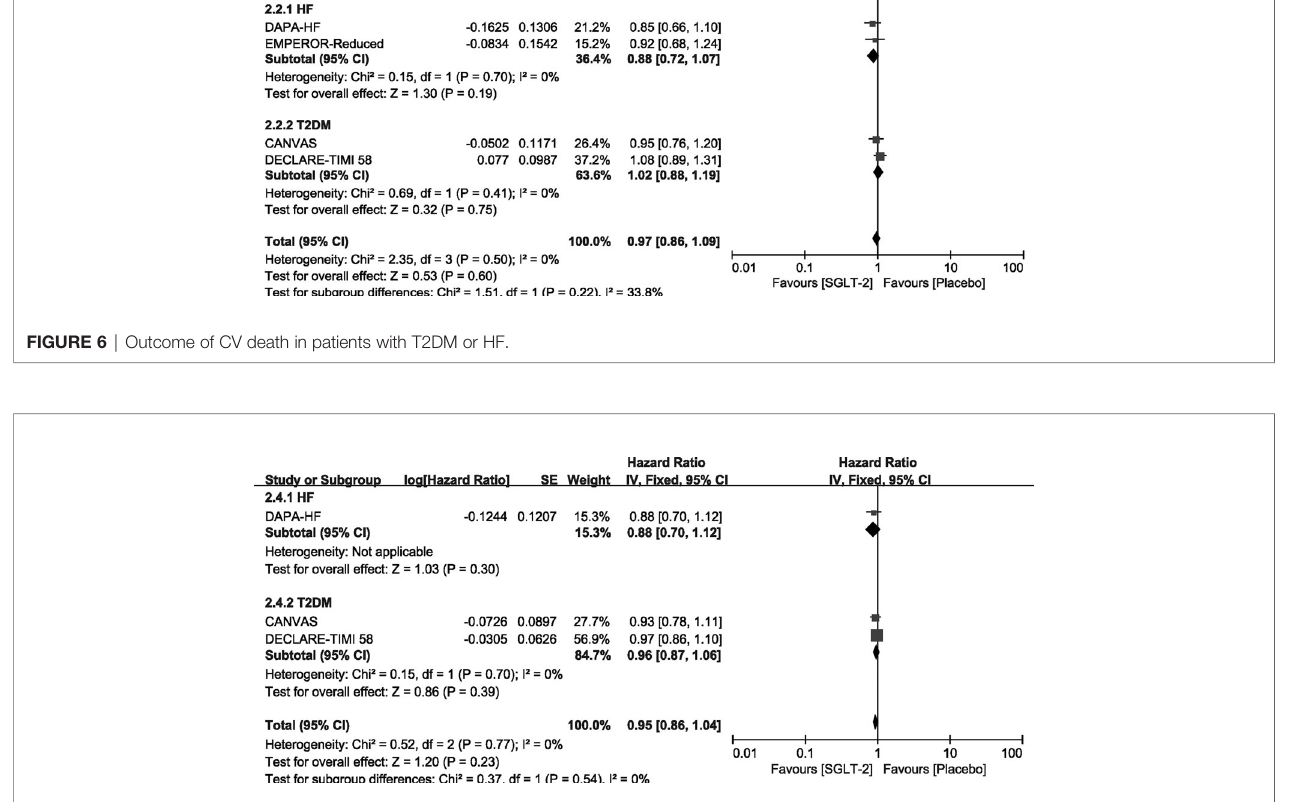
FIGURE 7 | Outcome of all-cause mortality in patients with T2DM or